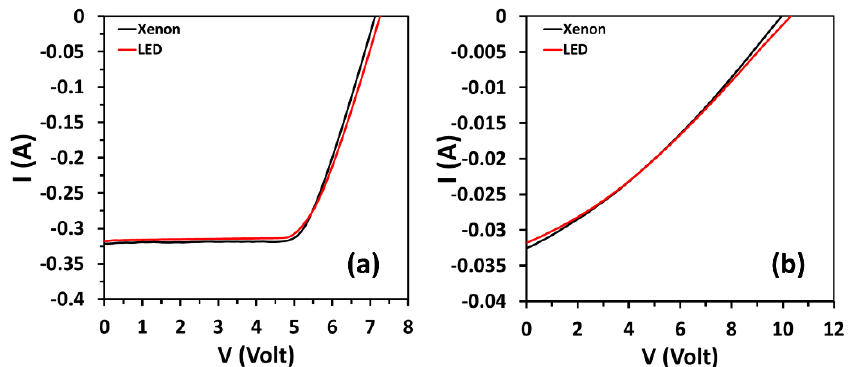
Figure 10. The IV curves of two types of solar cell tested under the xenon and LED solar simulator: ( a ) silicon and ( b ) large-area 26 cm × 16 cm printed OPV array. Table 5. Comparative values for Si and OPV cells under